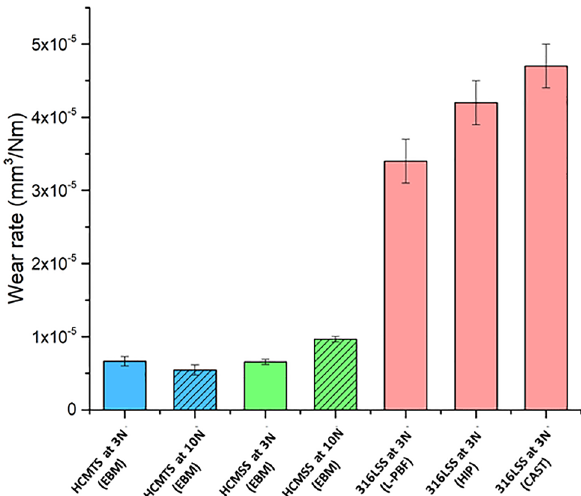
Figure 4. Specific wear rates of EBM-processed high carbon martensitic stainless steel (HCMSS), EBM- processed high carbon martensitic tool steel (HCMTS) and L-PBF-, cast- and high isotropic pressing (HIP)- processed austenitic stainless steel (316LSS) at different applied loads. The scatter bars show the standard deviation of the measured values. The data for austenitic stainless steel was retrieved from 8